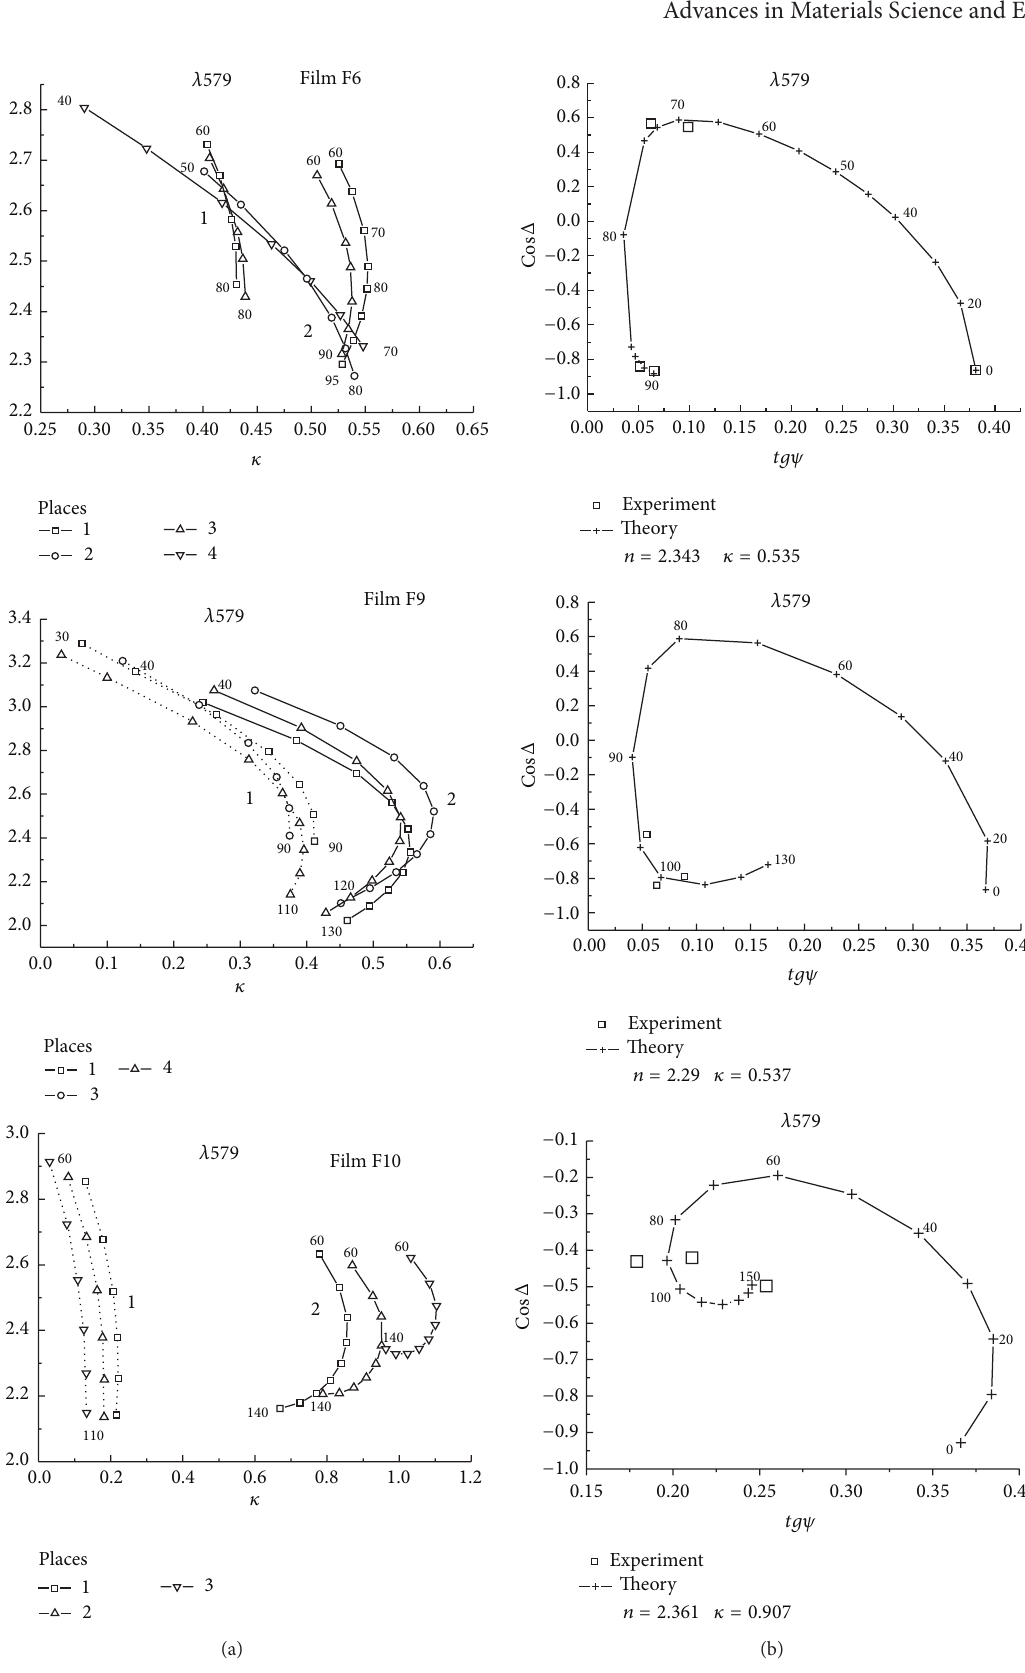
Figure 3: Range of possible values for the refractive index 𝑛 and index of extinction 𝜅 (a; curves), calculated for CdTe films on CdHgTe; comparison of experimental data with calculated dependence of ellipsometric parameters cos Δ and 𝑡𝑔𝜓 on film thickness (b). Numbers near markers specify the film thickness in nm. Numbers 1 and 2 indicate solution